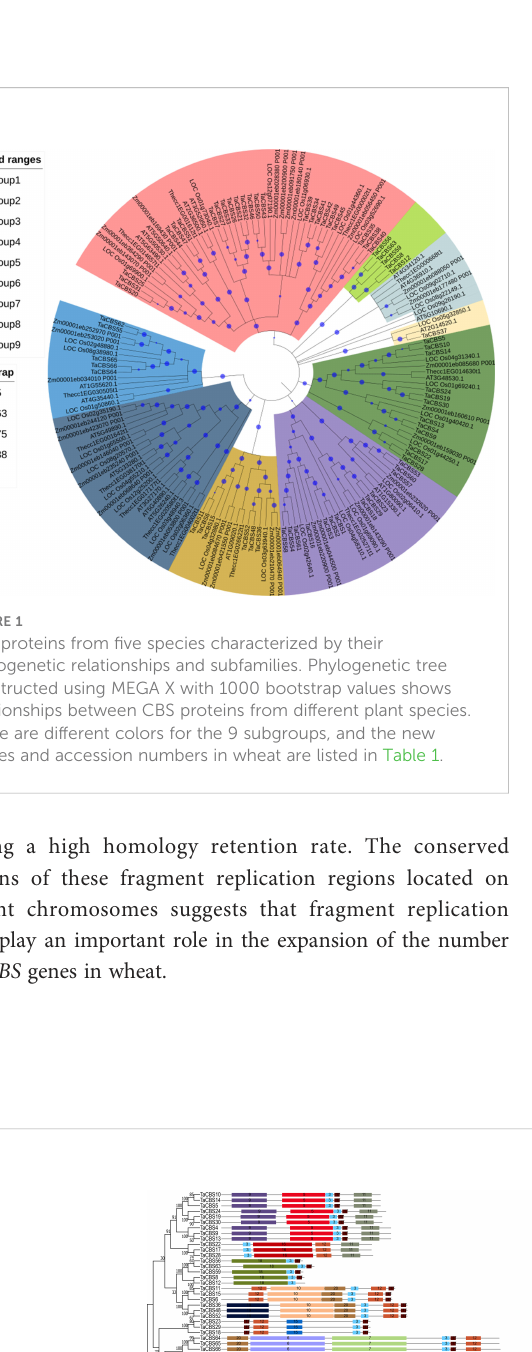
FIGURE 2 Phylogenetic relationship, conserved motifs, gene structure, and conserved domain of TaCBS proteins. Different colors are used to represent different motifs in the fi gure and in the upper right corner. Black lines represent non-conserved sequences in MEME results and introns in the exon-intron structure, respectively. The phylogenetic tree is constructed similarly to Figure